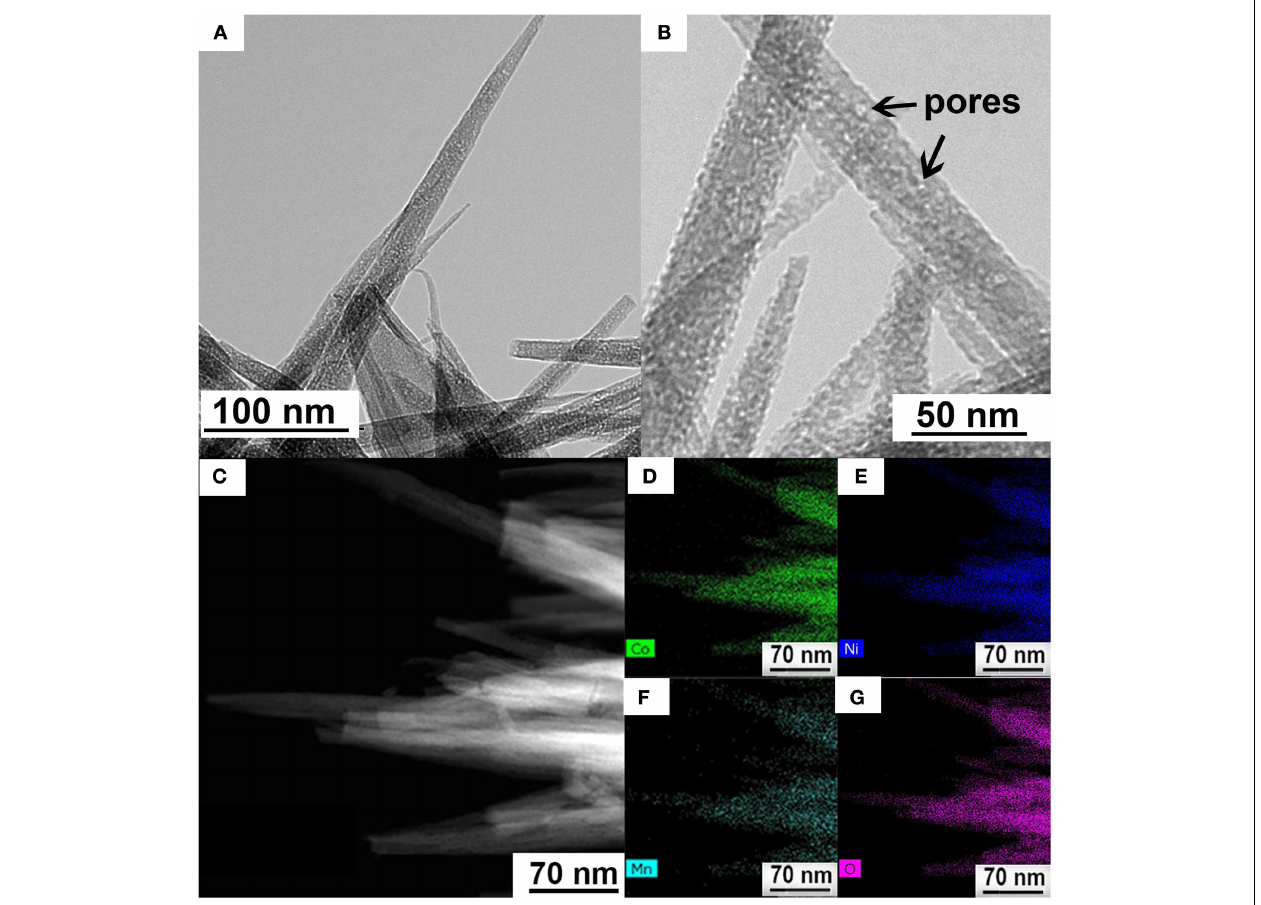
FIGURE 2 | (A) TEM image of Ni–Co–Mn oxide nanoneedles. (B) High-resolution TEM image showing the porous structure. (C) High-angle annular dark field (HAADF) scanning TEM image. (D–G) Elemental mapping showing uniform spatial distribution of mapped elements in the nanoneedles: (D–G) are Co, Ni, Mn, and O maps,